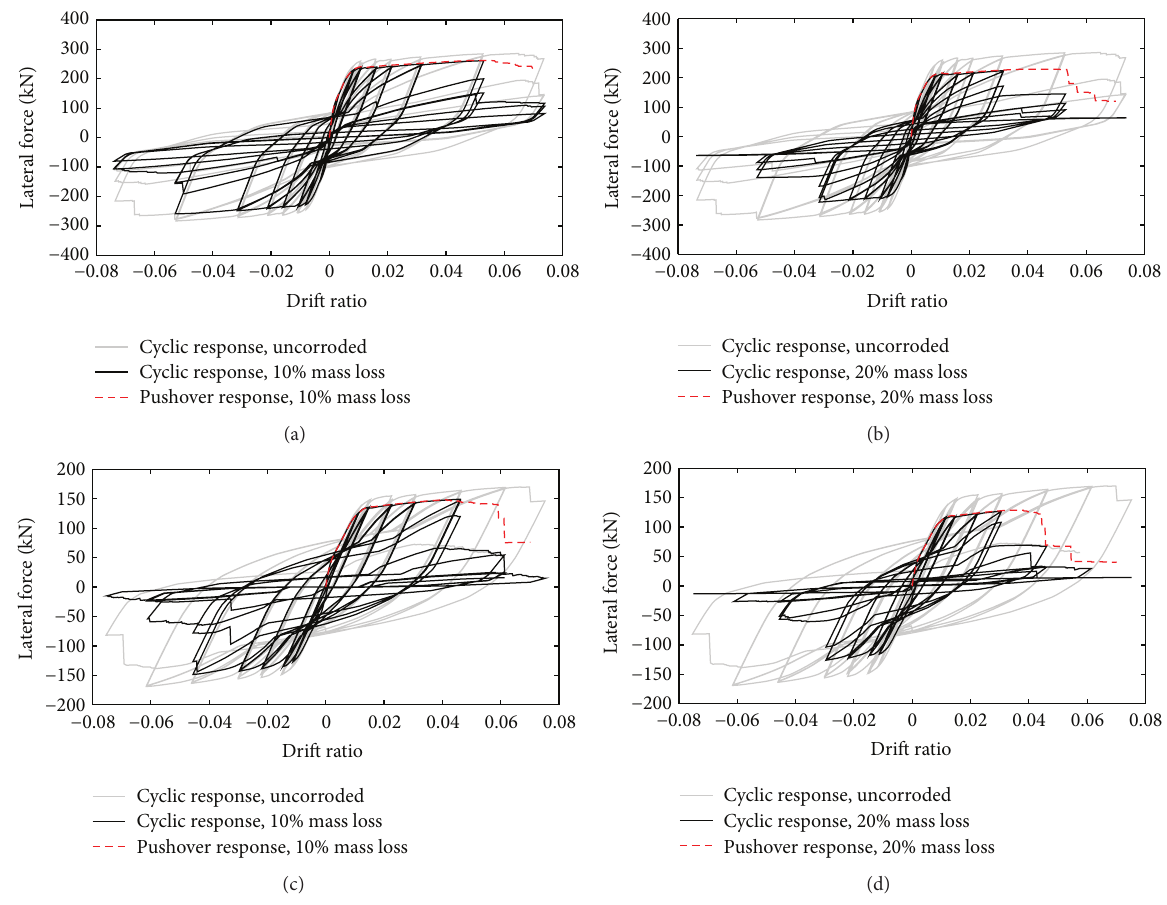
Figure 10: Cyclic analyses considering corrosion induced damage in reinforcing steel: (a) and (b) Lehman’s column 415; (c) and (d) Moyer and Kowalsky’s column 1.